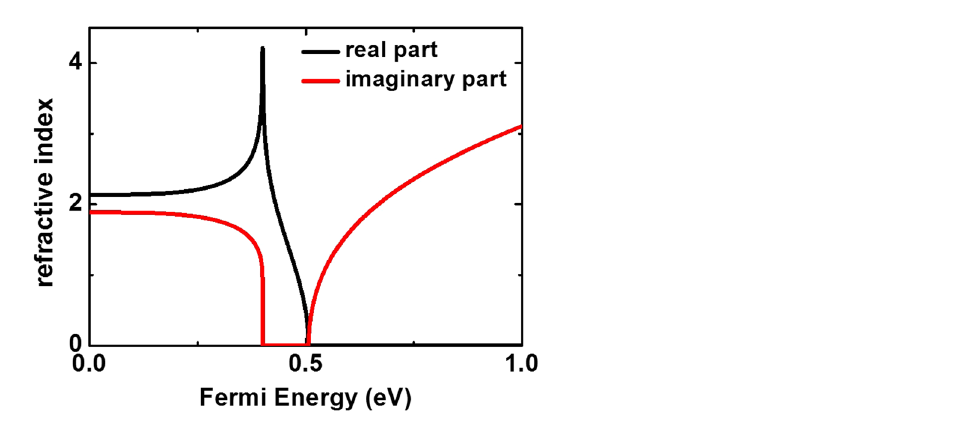
Figure 2. The refractive index of monolayer graphene varies with the Fermi energy (details see Methods). The black line and the red line represent the real part and imaginary part of the refractive index,